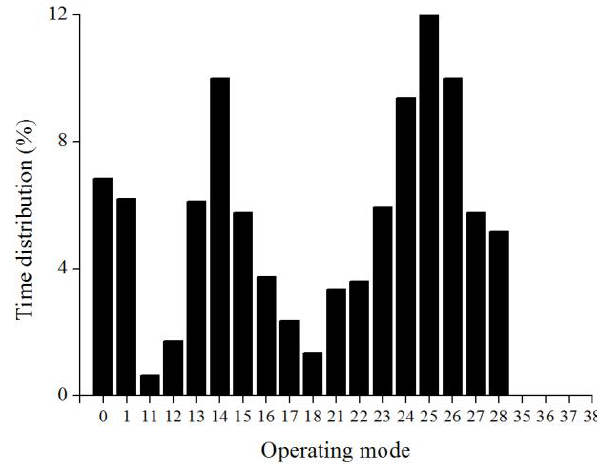
Fig. 4. Allocation of time of each operating mode bin to total time of the typical driving cycle for trucks in Beijing, with an average speed of 40kmh − 1